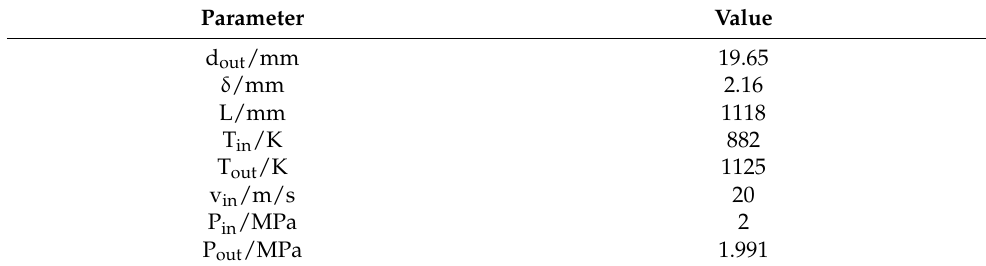
Figure 17. The model used in the numerical simulation study by Huang et al. [29]. Table 8. Parameters of the annular coolant channel model [29].